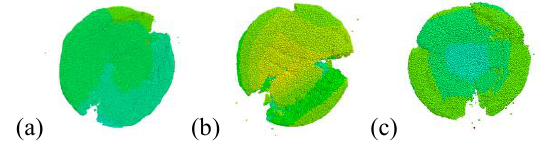
Fig. 11. Compressive crushing modes of LWCA particle in DEM simulations: (a). two-part fracture, (b). three-part fracture, (c). four-part